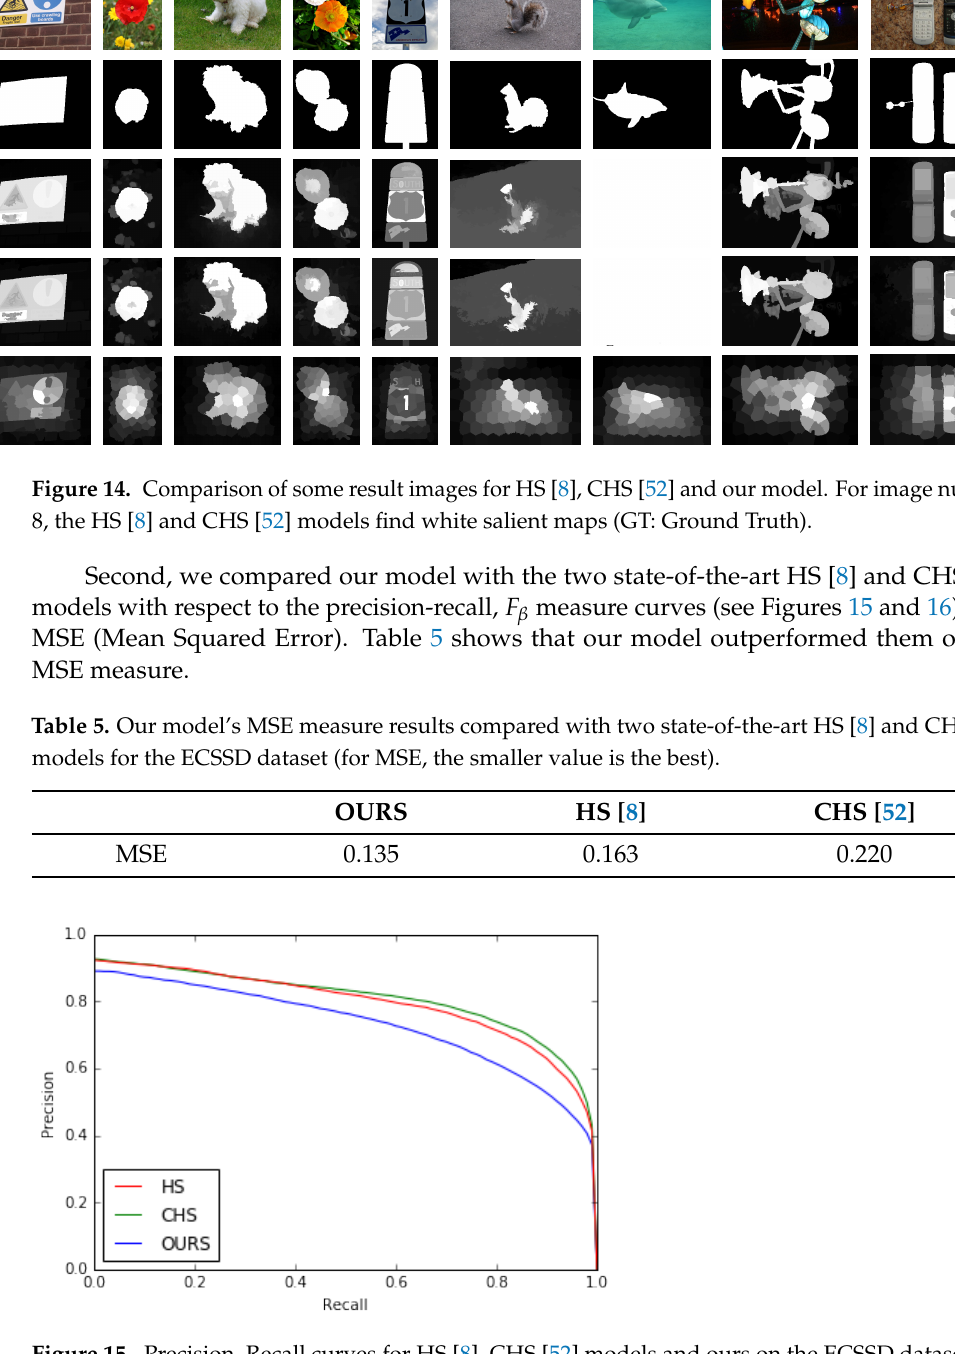
Figure 15. Precision–Recall curves for HS [8], CHS [52] models and ours on the ECSSD